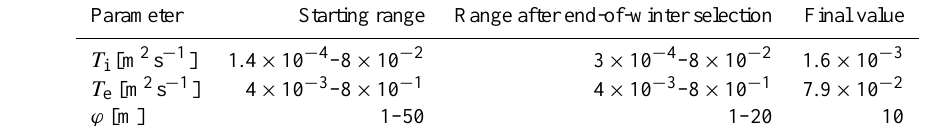
Table 3. Values of the tunable hydrological parameters for the different steps of the selection procedure.